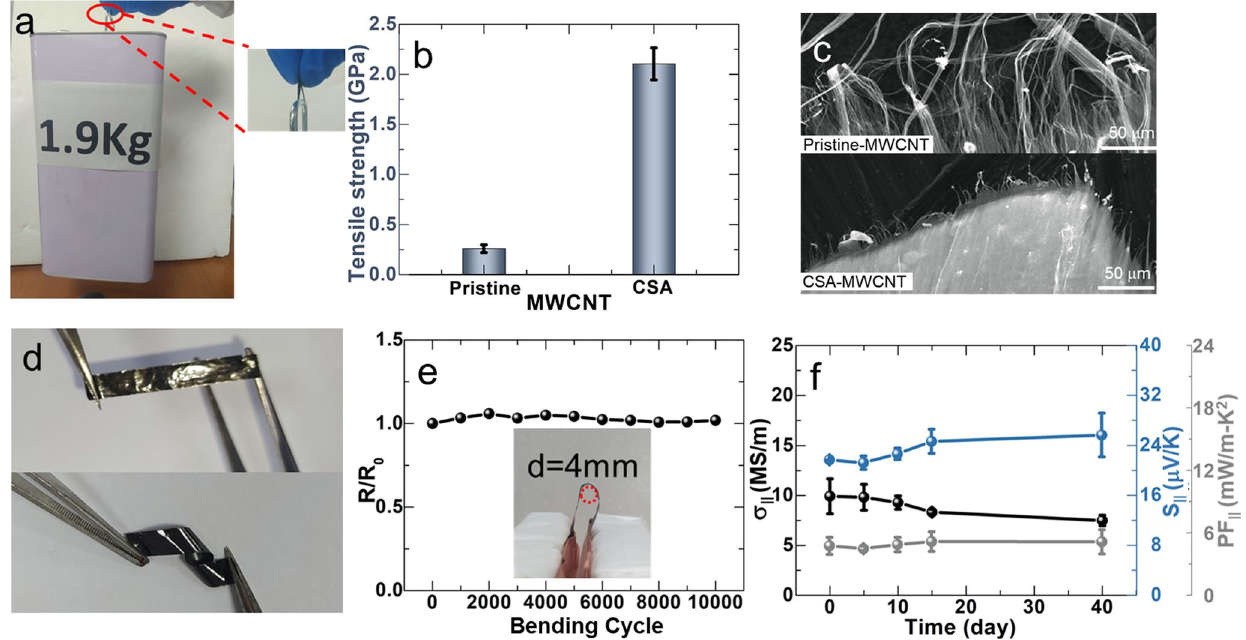
Fig. 3 | Mechanical properties and stability characterization of MWCNT fi lms. a The optical images of a water bottle of ∼ 1.9Kg lifted by CSA-MWCNT fi lm. The tensilestrength( b )andSEMimagesoffracturesurfaces( c )ofpristine-MWCNT fi lm